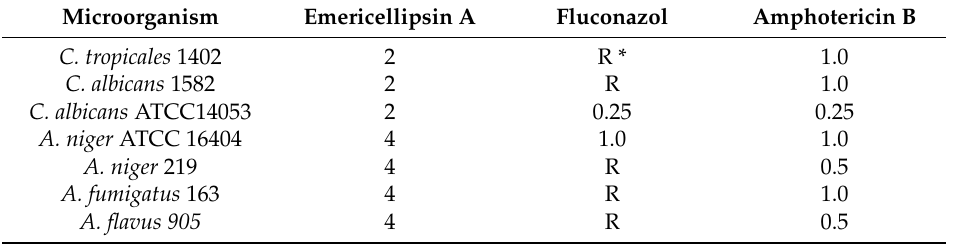
Table 3. Minimum Inhibitory Concentrations (MIC) of the emericellipsin A against fungi, µ